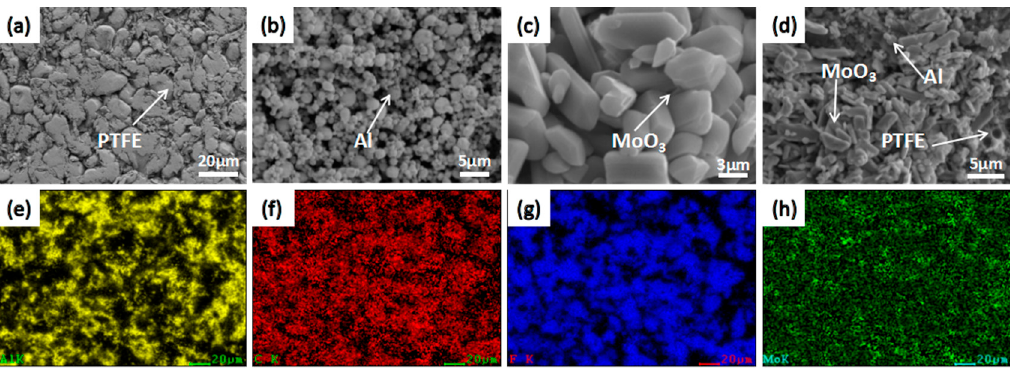
Figure 5. Microstructures and element distribution of the raw materials and a sintered specimen. ( a ) PTFE; ( b ) Al; ( c ) MoO 3 ; ( d ) PTFE/Al/MoO 3 ; ( e ) Al element; ( f ) C element; ( g ) F element; ( h ) Mo element.